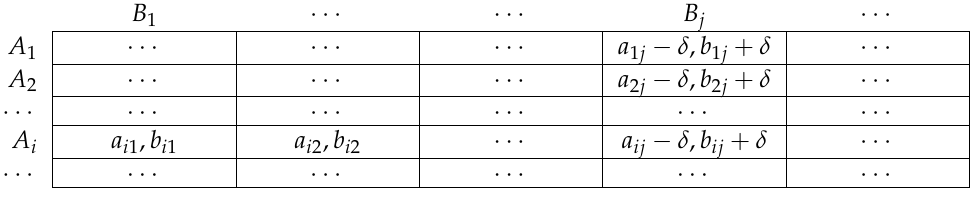
Figure 2. The transformed payoff matrix after an offer A